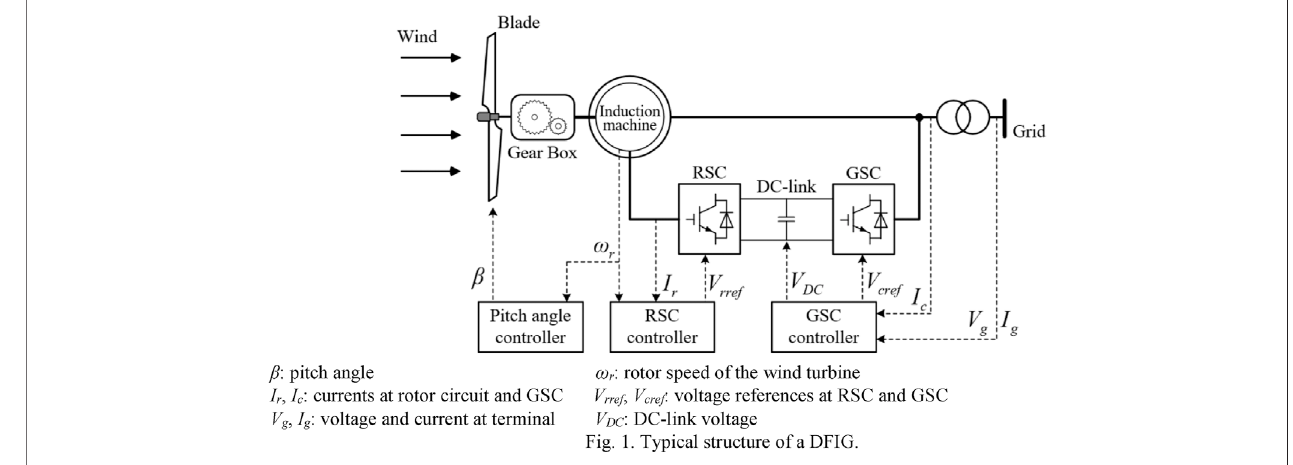
FIGURE 1 | Typical structure of a DFIG.